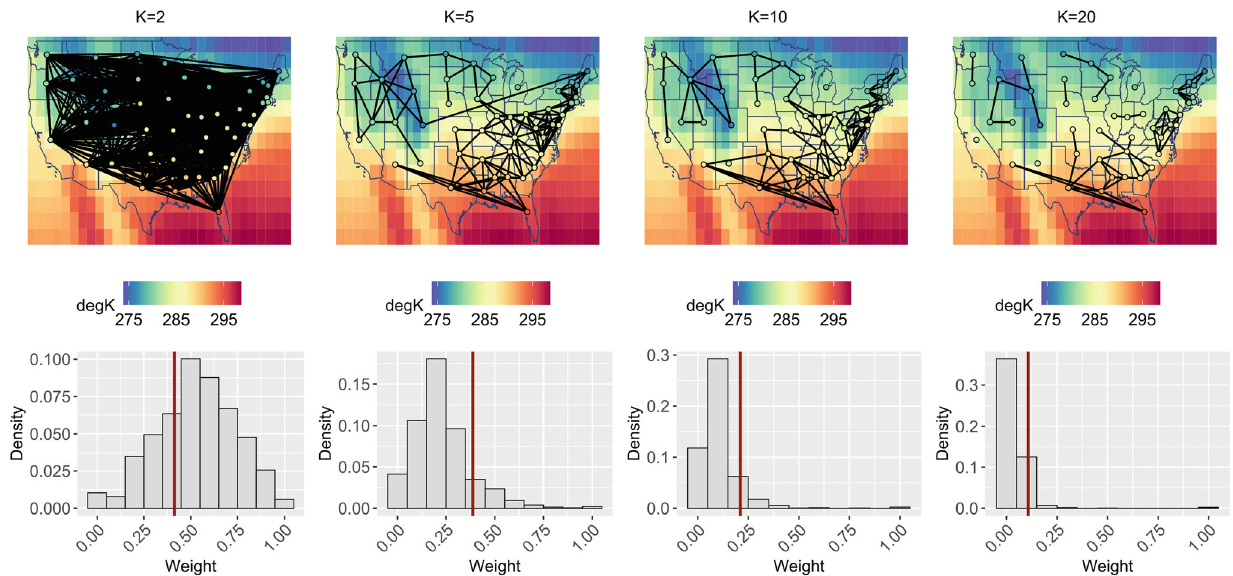
Fig. 9 Topologies inferred from temperature time series detection scale of larger k is small, and the detected links are more closely related. Overall, the inferred topologies tend to link neighboring states, consistent with common sense that neighboring states tend to have similar